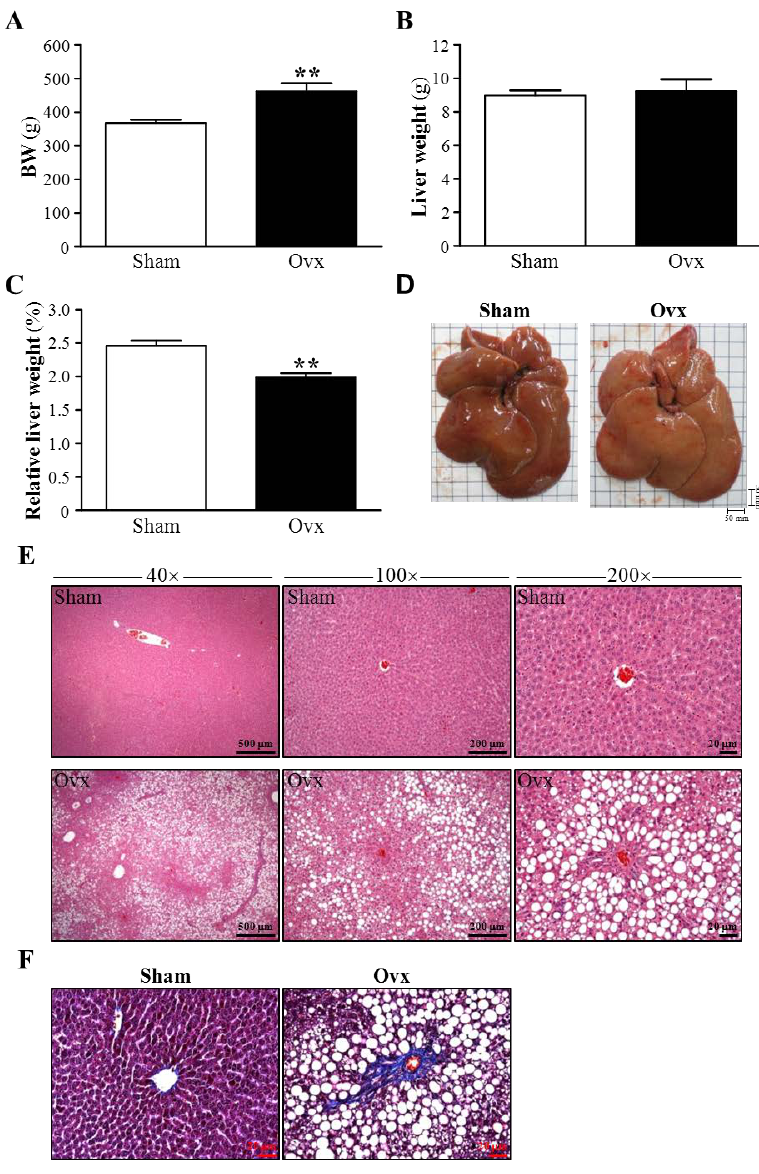
Figure 2. Effect of Ovx on liver gross and hi stopathology. ( A ) The body ( B ) liver weight and ( C ) liver mass/body weight ratio (relative liver weight, %) of Sham and Ovx rats at 4 months after ovariectomy. Mean ± SEM ( n = 8). ** p < 0.005 versus Sham group; ( D ) Excised livers of Sham and Ovx rats; ( E ) Histological sections of the livers from Sham and Ovx rats with H&E staining. Specimens were photographed under a light microscope at 40 × , 100 × , and 200 × magnification, and scale bars represent 500, 200, and 20 µ m, respectively; ( F ) Histological sections of the livers from Sham and Ovx rats with Masson trichrome staining for collagenous scar tissue. Scale bars, 20 μm (magnification, 200×).